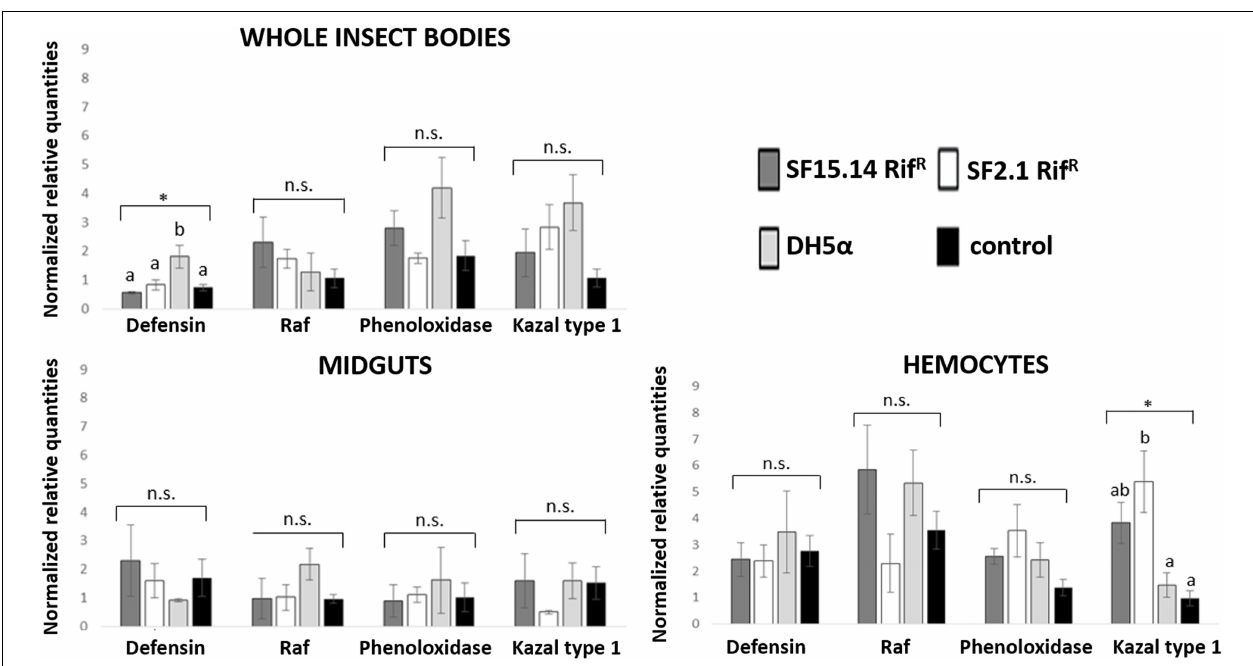
FIGURE 2 | Expression profiles of immune-related genes in E. variegatus samples of the healthy group. Gene expression was measured in the whole bodies, midguts, and cultured hemocytes of adults treated with Asaia SF15.14Rif R , Asaia SF2.1Rif R , and E. coli DH5 α pKan(DsRed), along with the control. Normalized relative quantities, calculated by 2 - (cid:49)(cid:49) Ct method, are indicated for defensin , Raf , phenoloxidase , and kazal type 1 serine protease inhibitor genes. Bars indicate standard errors. Asterisks show significant differences according to ANOVA ( P < 0.05); different letters indicate significantly different values according to Tukey’s test (a < b). DH5 α : E. coli DH5 α pKan(DsRed); n.s., not significant.